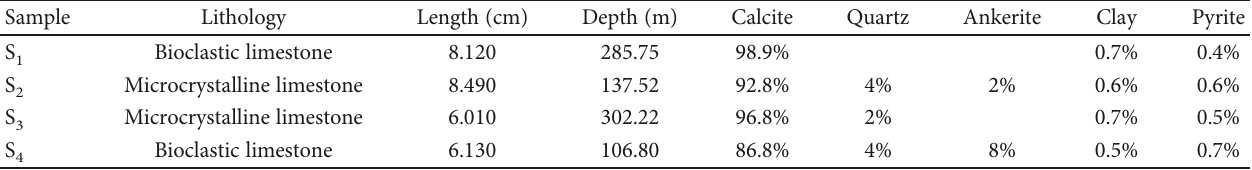
Table 1: Lithology, length, depth, and mineralogical composition of the carbonate samples.